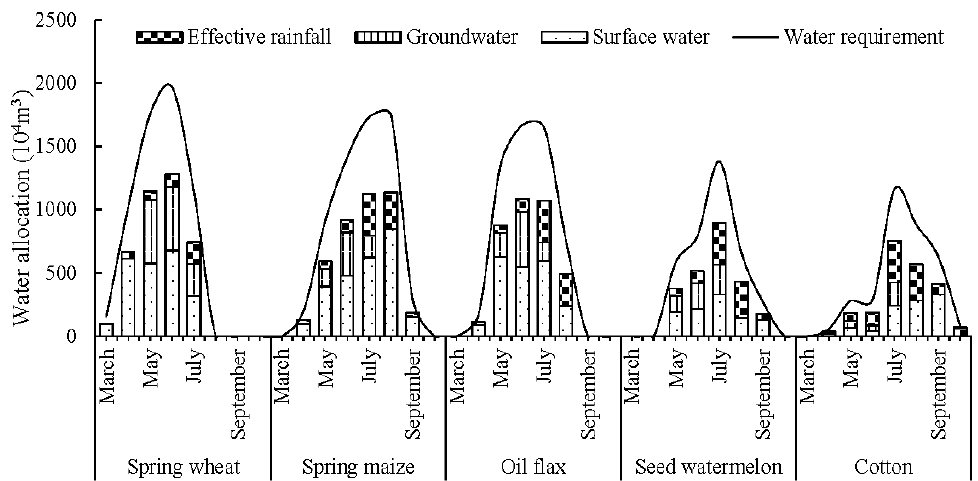
Figure 5. Optimal water allocation amount for typical crops in different months.